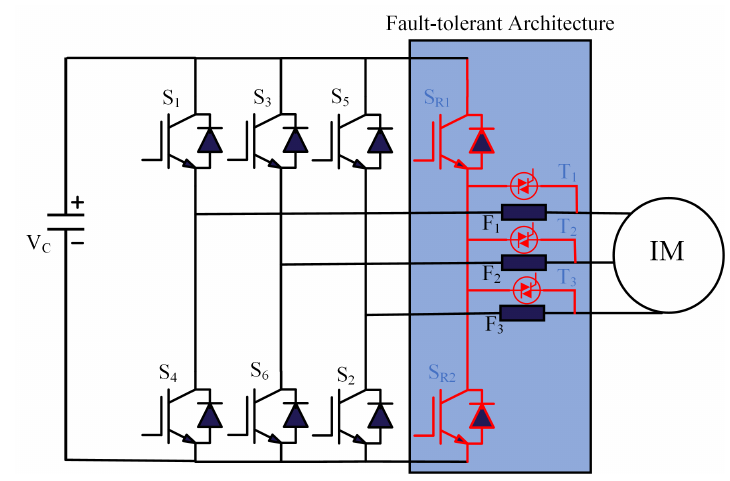
Figure 3. Proposed fault-tolerant